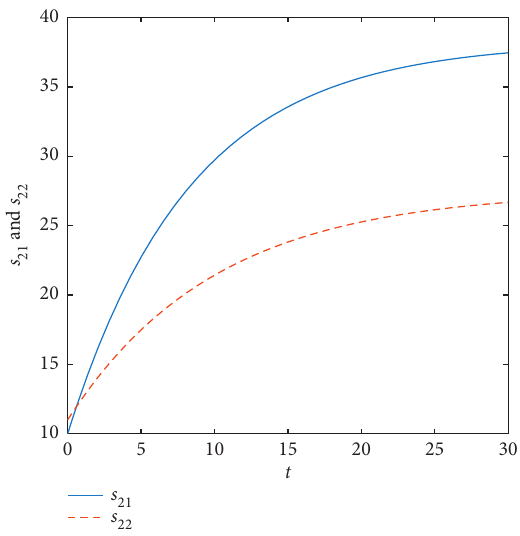
Figure 9: The pollution stock trajectory of the downstream region under